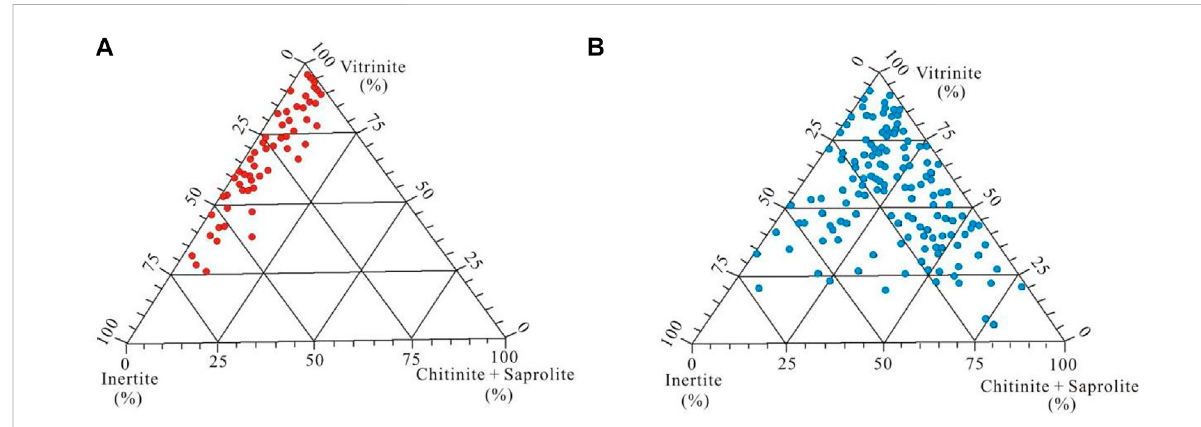
FIGURE 2 Microscopic composition of Jurassic coal (A) and mudstone (B) in the Yanqi Basin.